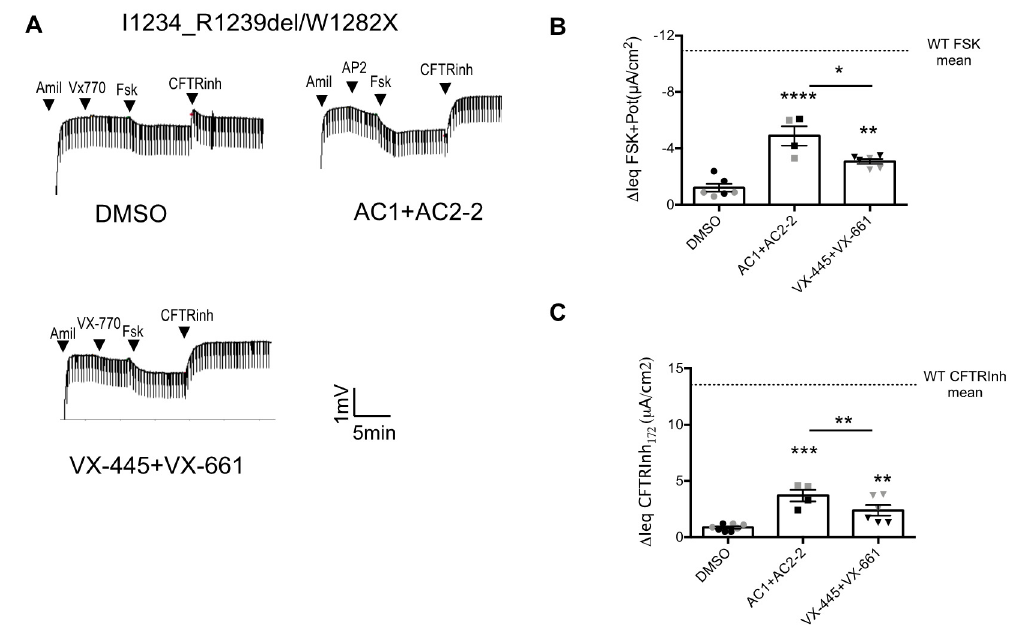
Figure 3. Nasal epithelial cultures derived from 2 patients bearing I1234_R1239del/W1282X mutation showed a minimal CFTR rescue by the novel triple combination. ( A ) Representative tracing show Ussing chamber measurements of transepithelial potential difference trace of I1234_R1239del/W1282X-CFTR in nasal cell cultures pre-treated with DMSO, 3 µM VX-661 + 3 µM VX-445 or 0.5 µM AC1 + 3µM AC2-2 for 48 h at 37 °C. ( B ) Bar graph showing mean peak responses (Ieq (µA/cm 2 ± SEM) to forskolin (10 µM) and VX-770 (1 µM) or AP2 (1.5 µM) activated Ieq for nasal cultures from 2 patients after pre-treatment for 48 h with CFTR correctors Modulators were tested in 2–3 cultures for each patient with each data from each patient showed as grey or black symbols; peak value for culture shown as dot. ( C ) Bar graphs showing the IeqCFTR inhibition (µA/cm 2 ) by CFTRInh-172 (10 µM). (* p < 0.05, ** p < 0.01, *** p < 0.001, **** p < 0.0001).